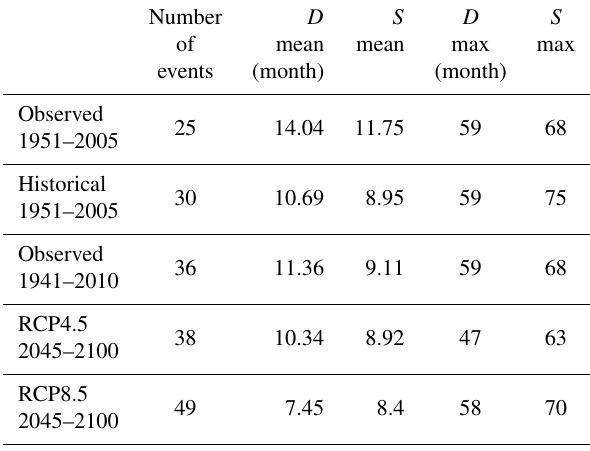
Table 1. Number and mean severity and duration of drought events, and maximum severity and